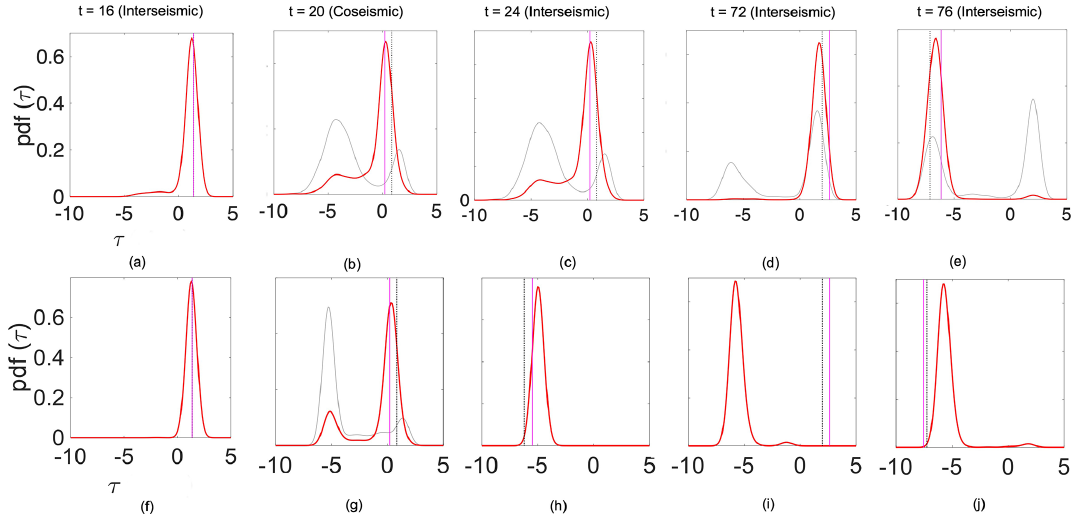
Figure 10. The pdfs for the case with (a–e) joint state-parameter estimation and (f–j) state estimation with intermediate bias in Fig.